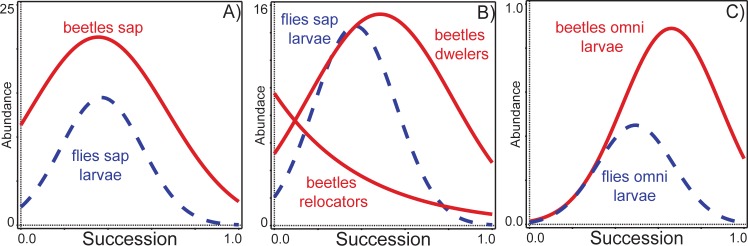
Successional trends in dung-inhabiting beetles and flies.A) beetle (solid red line) and fly larvae (dashed blue line) saprophages (sap); B) beetle relocators and dwellers (solid red lines) and fly larvae (dashed blue line) saprophages (sap); C) beetle omnivorous larvae (omni: solid red line) and fly omnivorous larvae (omni: dashed blue line).